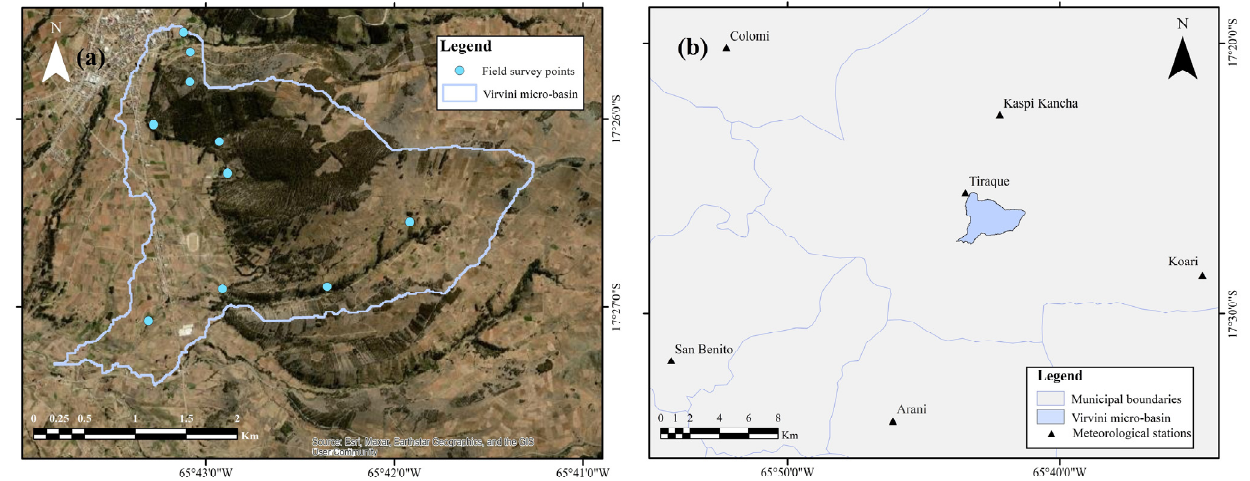
Figure 6. ( a ) Location of the ten survey points for identifying plant communities within the limits of the Virvini micro-basin; and ( b ) location of the meteorological stations near the Virvini